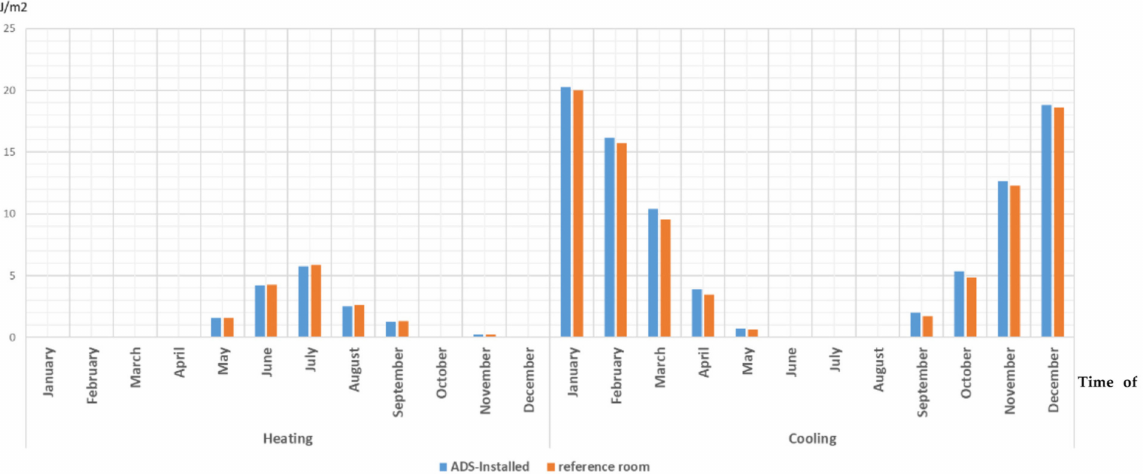
Figure 17. Comparison of yearly heating and cooling load for the reference room and the room equipped with an